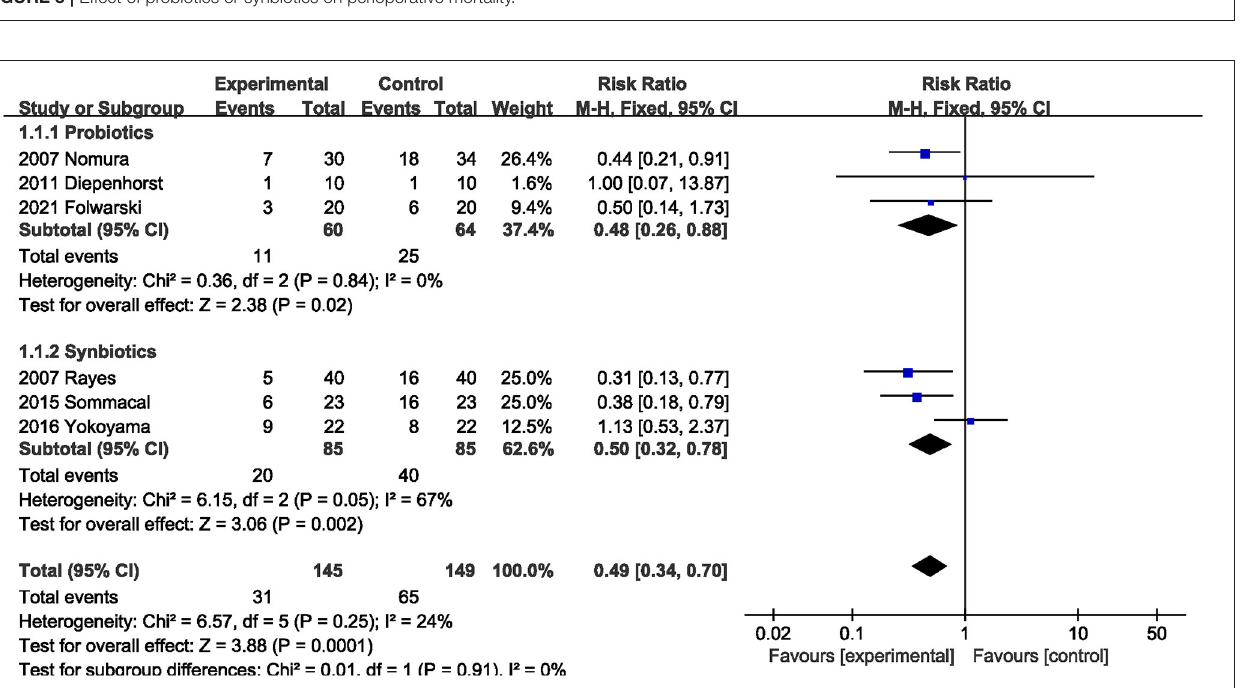
FIGURE 3 | Effect of probiotics or synbiotics on perioperative mortality.